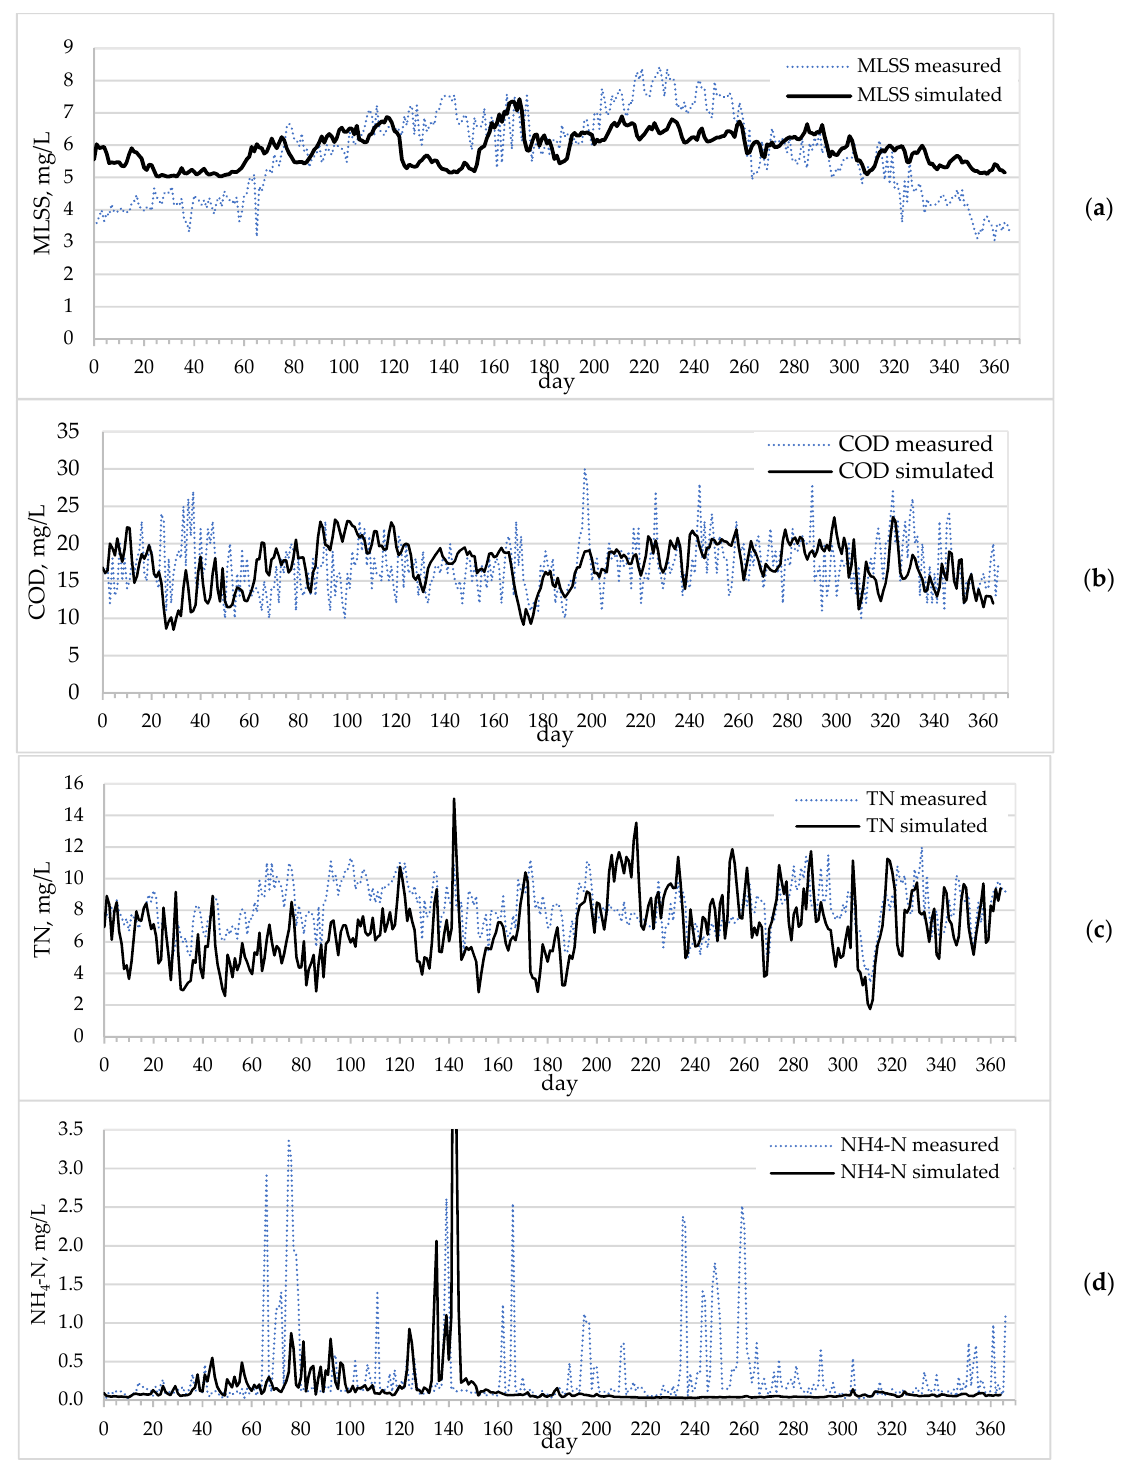
Figure 7. Model calibration results: ( a ) MLSS concentration; ( b ) Effluent concentration of COD; ( c ) TN; ( d ) NH 4 -N. Measured in laboratory (dashed blue), simulated values (black).